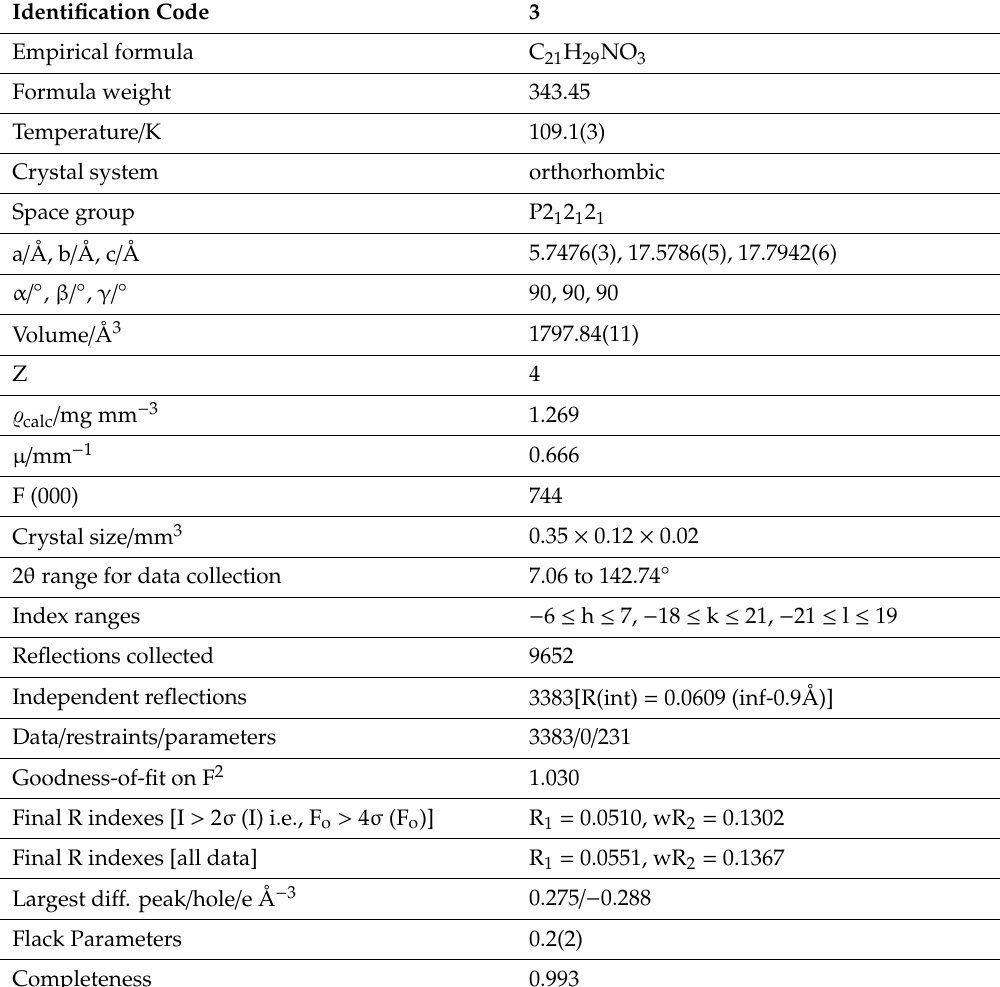
Table 2. Crystal data and structure refinement for